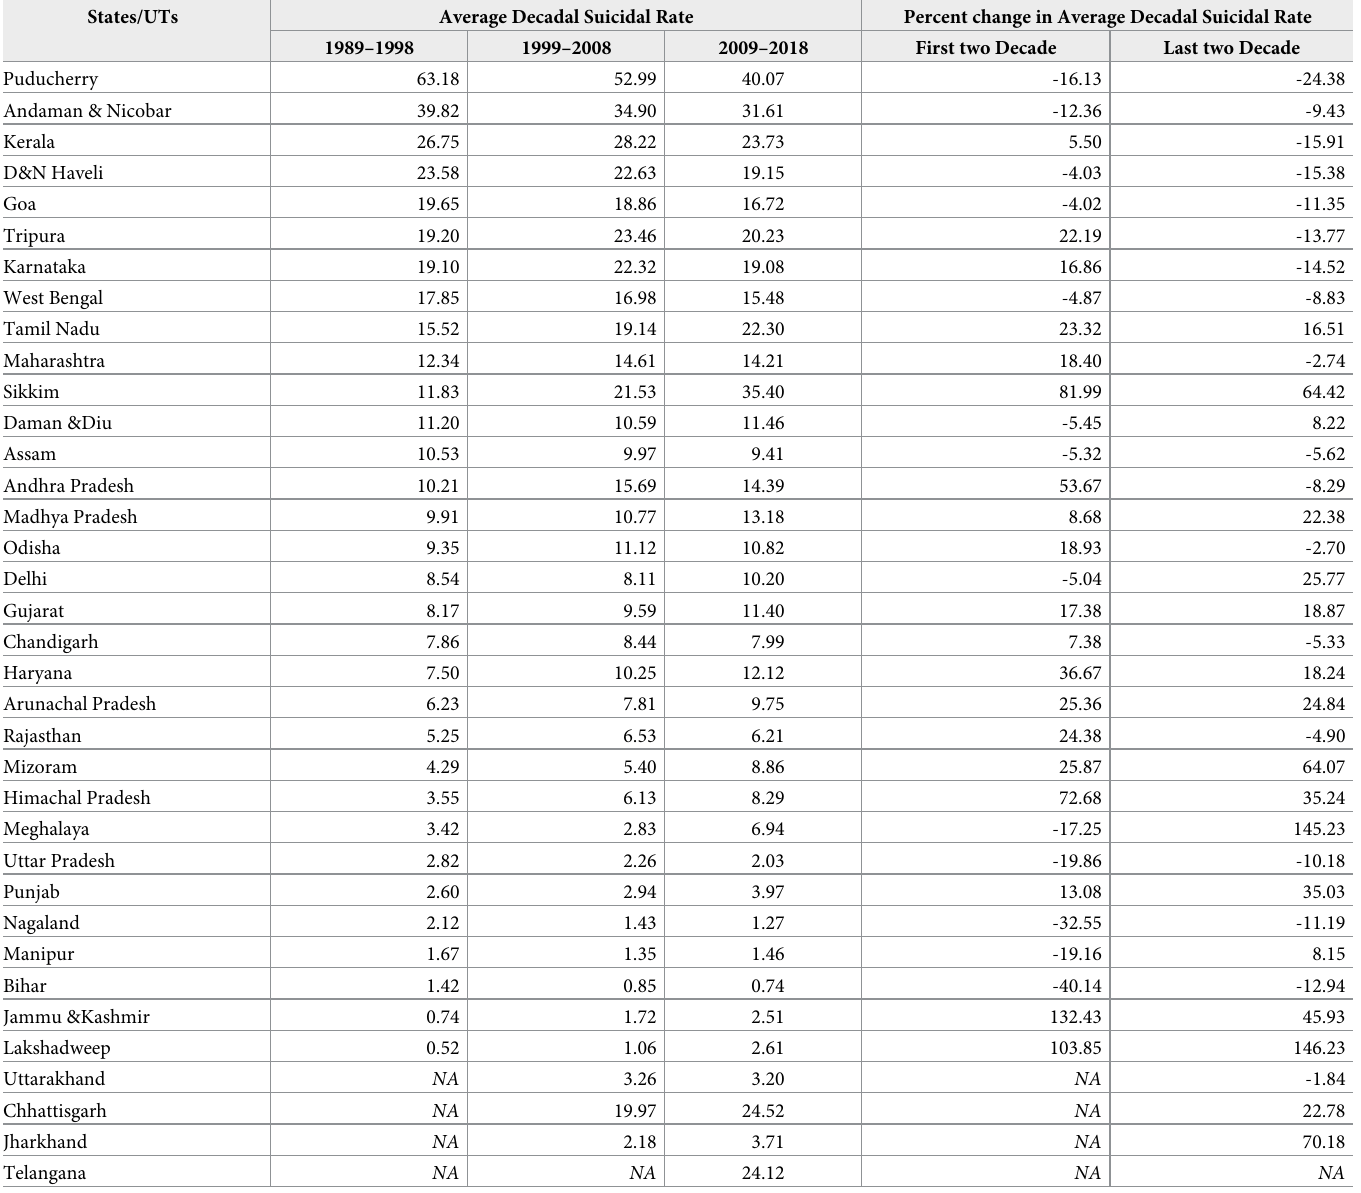
Table 2. Trends of suicide rates in different states/UTs of India over last 3